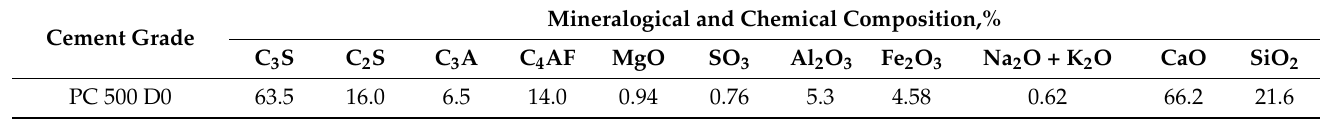
Table 2. Mineralogical and chemical composition of Portland cement.